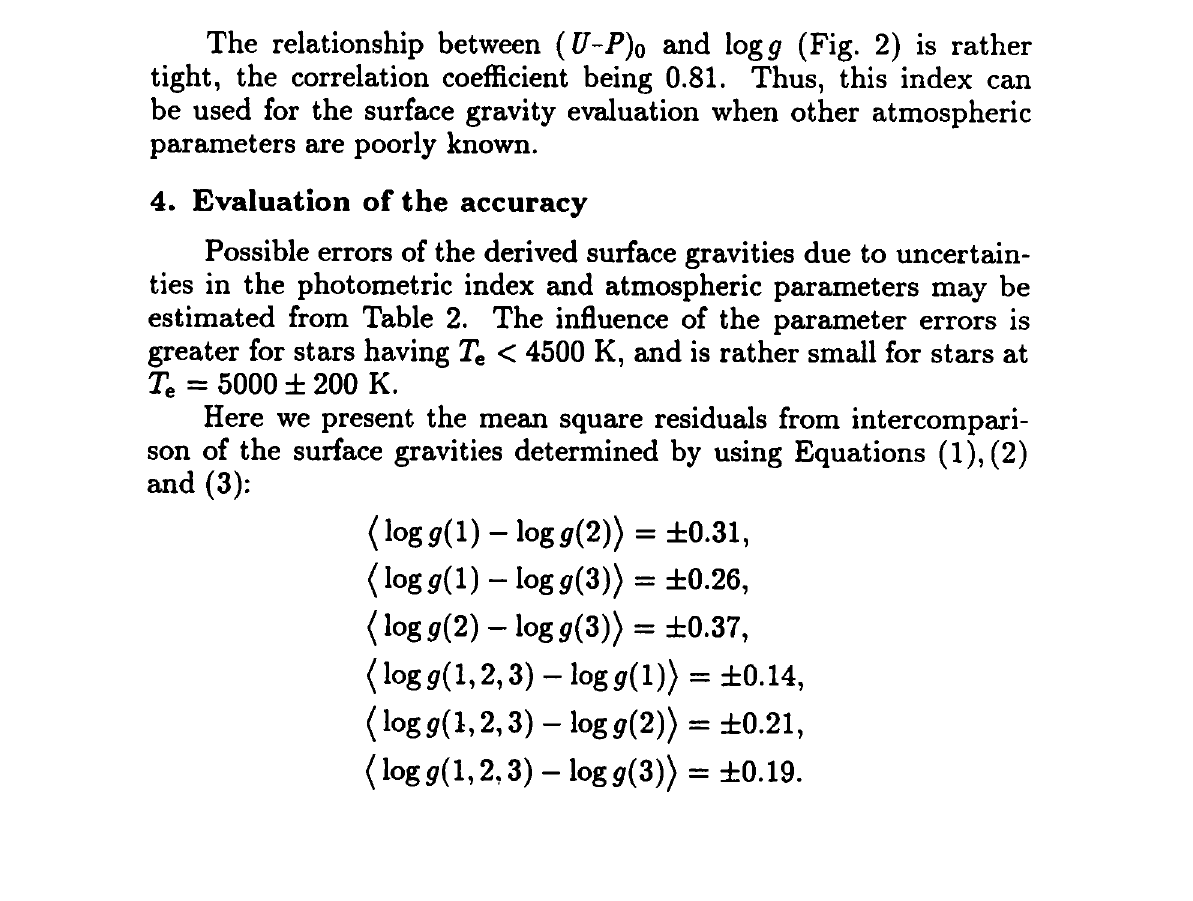
Fig. 2. Dependence of log g on the intrinsic colour indices ( U-P) o. The relationship between (U-P) ο and logg (Fig. 2) is rather tight, the correlation coefficient being